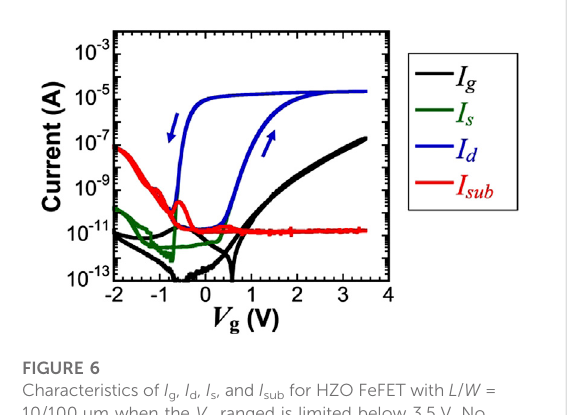
Characteristics of I g , I d , I s , and I sub for HZO FeFET with L / W = 10/100 μ m when the V g ranged is limited below 3.5 V. No substrate current I sub is observed at positive V g